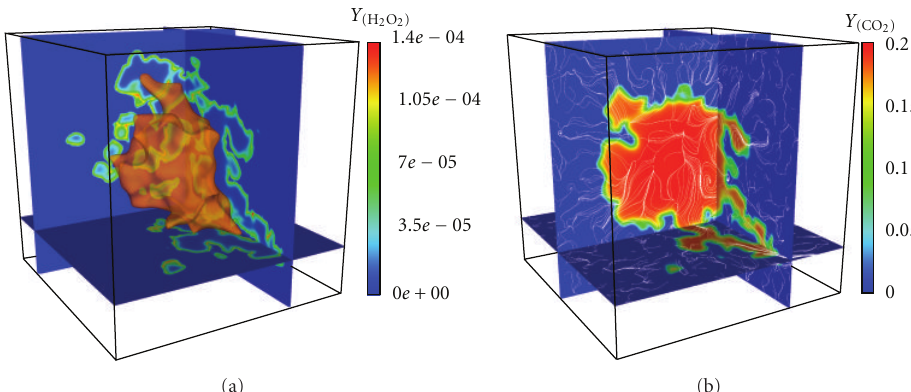
Figure 2: General view of the configuration for the direct simulation, showing (a) the iso-surface of temperature with H 2 O 2 slices and (b) CO 2 slices with stream lines (thin white lines), revealing the heavily wrinkled flame front after interacting with the three-dimensional time-decaying homogeneous isotropic synthetic turbulent velocity field for 0.8